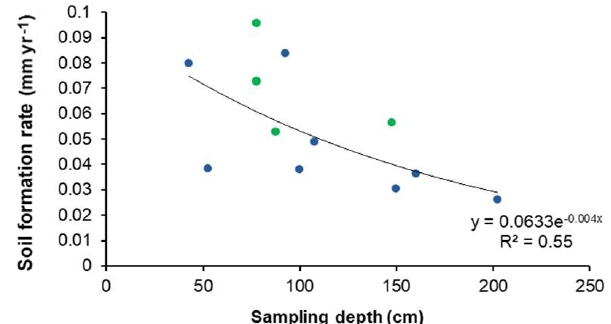
Figure 3. Soil formation rates against sampling depth for Rufford Forest Farm (blue; n = 8) and Comer Wood (green; n = 4). Depth here refers to that for the midpoint (between the top and bottom) of the